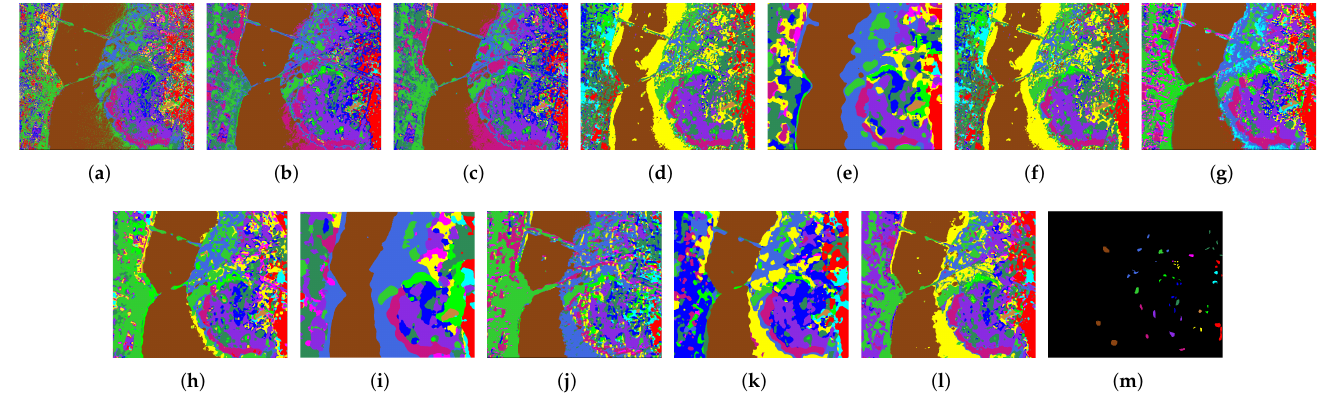
Figure 10. Classification maps for the KSC data set obtained by: ( a ) SVM, ( b ) CDCNN, ( c ) 3DCNN, ( d ) SSRN, ( e ) DFFN, ( f ) MFDN, ( g ) CBW, ( h ) FGSSCA, ( i ) LDN, ( j ) S2FEF, ( k ) S3EResBoF, ( l ) LMFN, and ( m ) Ground truth.